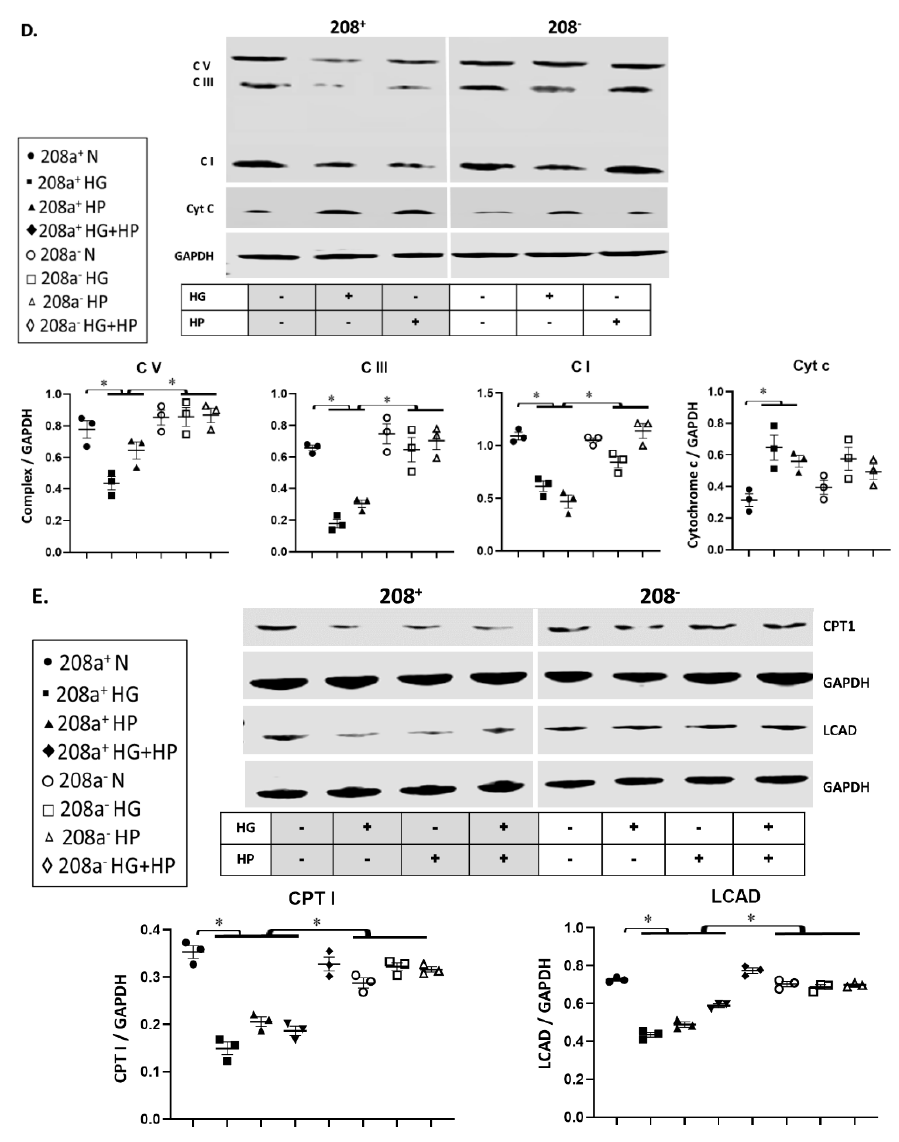
Figure 4. MiR 208a, mitochondrial biogenesis, and mitochondrial markers. SV40 human cardiomyocytes were incubated in DMEM with 5 mM glucose, 25 mM glucose (high glucose, HG), or 20 µM bovine serum albumin (BSA)-bound palmitate (high palmitate, HP) for 24 h. ( A ) Mitochondrial biogenesis factors. TRA, thyroid hormone receptor A; TFAM, mitochondrial transcription factor A; NRF1, nuclear respiratory factor 1. ( B ) PGC1 α , peroxisome proliferator-activated receptor γ -coactivator α . ( C ) Mitochondrial DNA. Total DNA was subjected to quantitative real-time PCR using a designed primer for mitochondrial NADH dehydrogenase 4 (ND4). ( D ) Mitochondrial marker proteins. C I, II, III, and V, complexes I, II, III, and V. ( E ) CPT1, carnitine palmitoyl transferase 1; LCAD, long-chain acylCoA dehydrogenase; GAPDH, glyceraldehyde 3-phosphate dehydrogenase. The lower panels represent the densitometric analyses of specific proteins per GAPDH. Results are expressed as the mean ± SEM of three independent experiments. * p < 0.05.